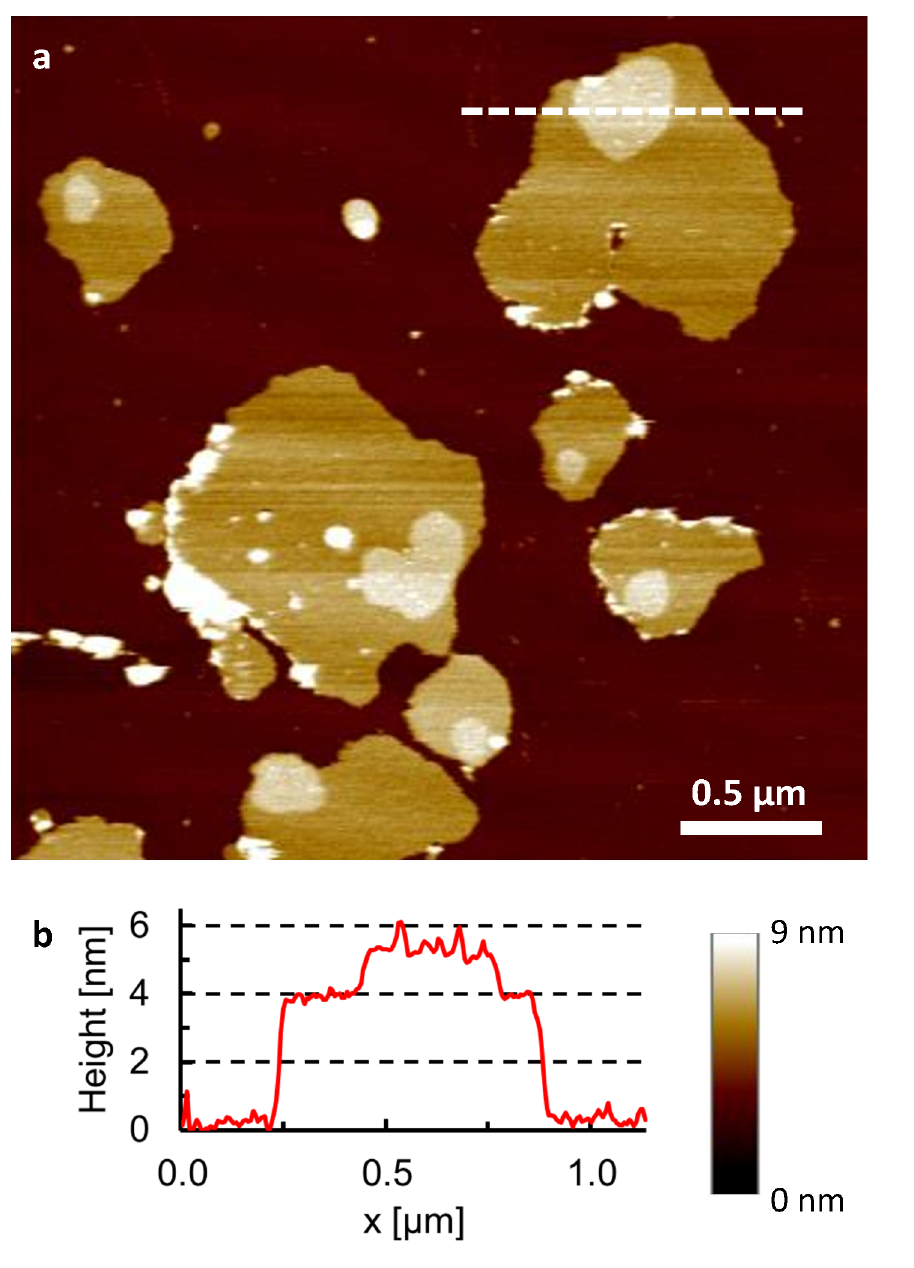
Fig 1. Microdomains in detergent-resistant membranes. a , AFM topography of detergent-resistant membranes (isolated on sucrose gradient, fraction 5) adsorbed on a mica substrate (dark brown), recorded in buffer solution at 25°C. Microdomains appear as elevated (brighter) plateaus with lateral dimensions of 100 – 300 nm on top of the membrane patches. b , Height profile corresponding to the white line drawn in (a).